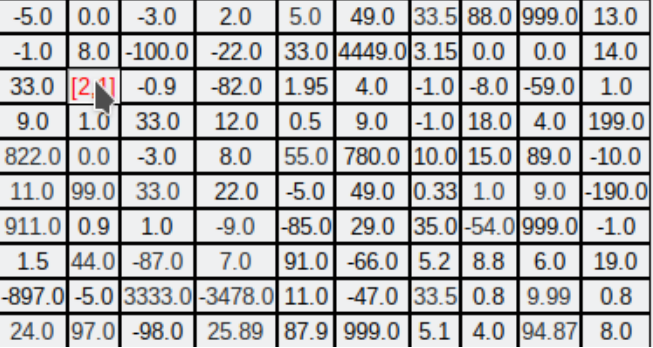
Figure 11. Canvas displaying the